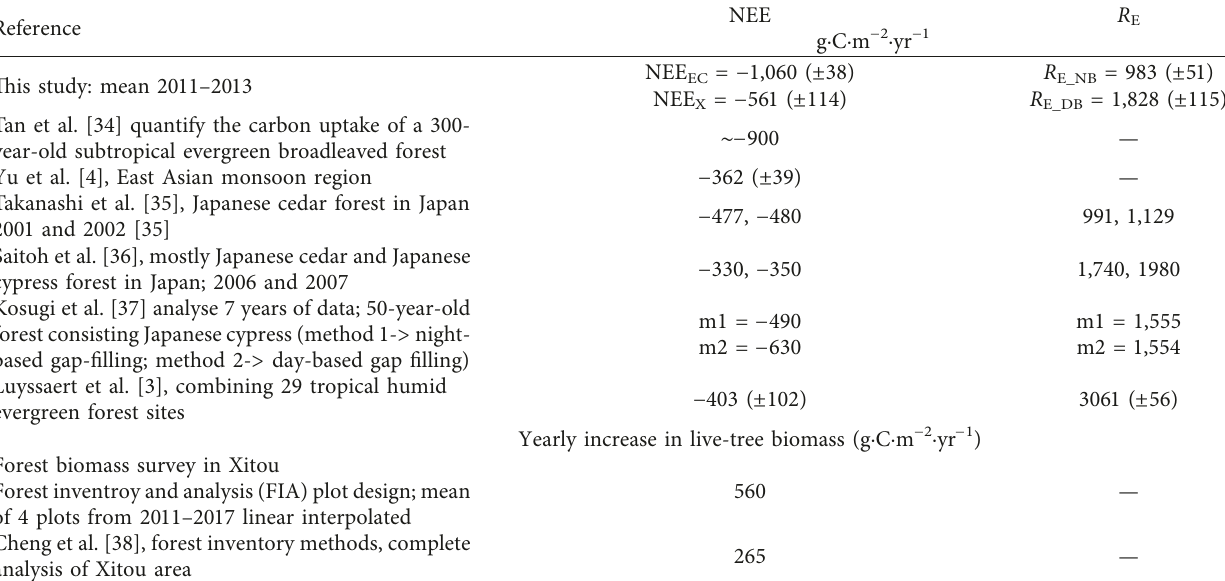
Table 4: Yearly sums of NEE and R E from this study and other studies. Estimates of yearly live-tree biomass with forest inventory methods (positive values represent carbon sequestration) around the flux tower and in the whole Xitou area. Numbers in parentheses are single standard deviations.